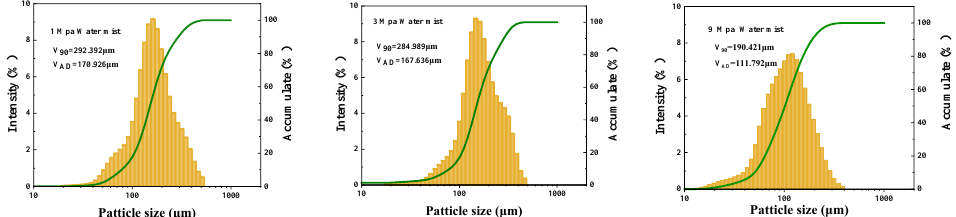
Figure 2. The patticle size distribution of water droplets from the nozzle of 7 L/min under different pressures.